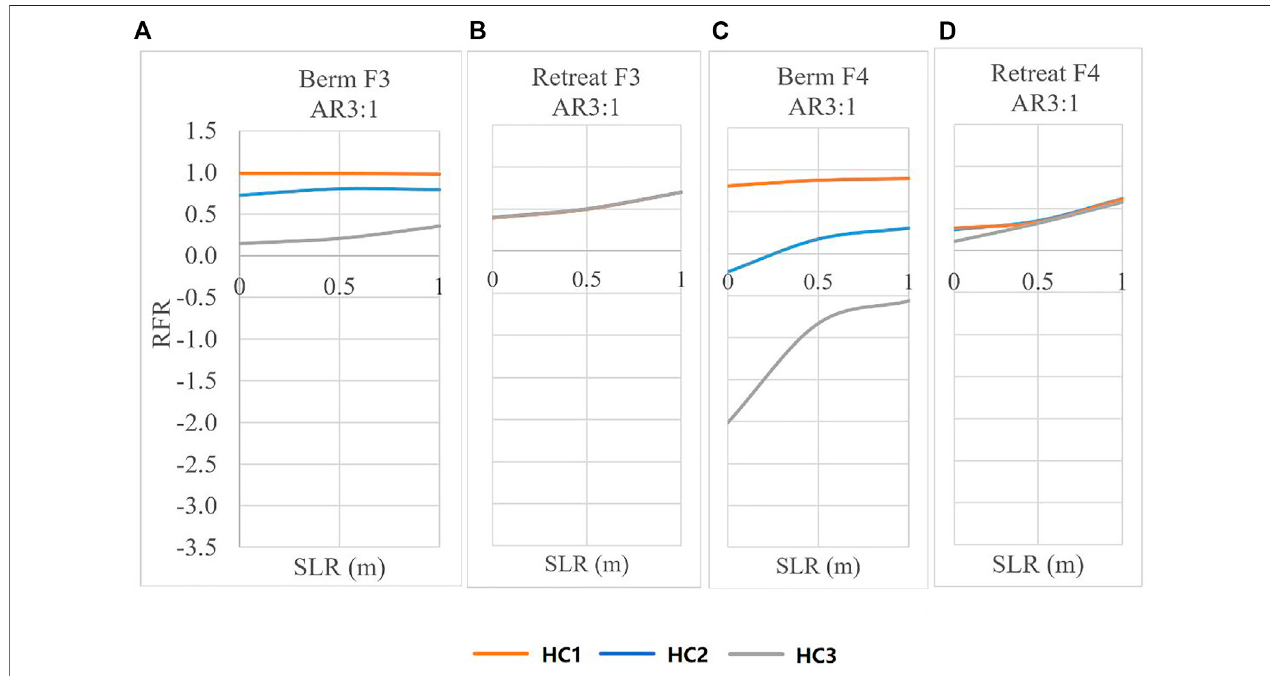
FIGURE 5 | Relative fatality reduction (RFR) under three storm climatology scenarios. (A,C) are berm results; (B,D) are retreat. (A,B) are results by model F3; and (C,D) are by F4. In (B,D) lines are not distinguishable due to overlapping.